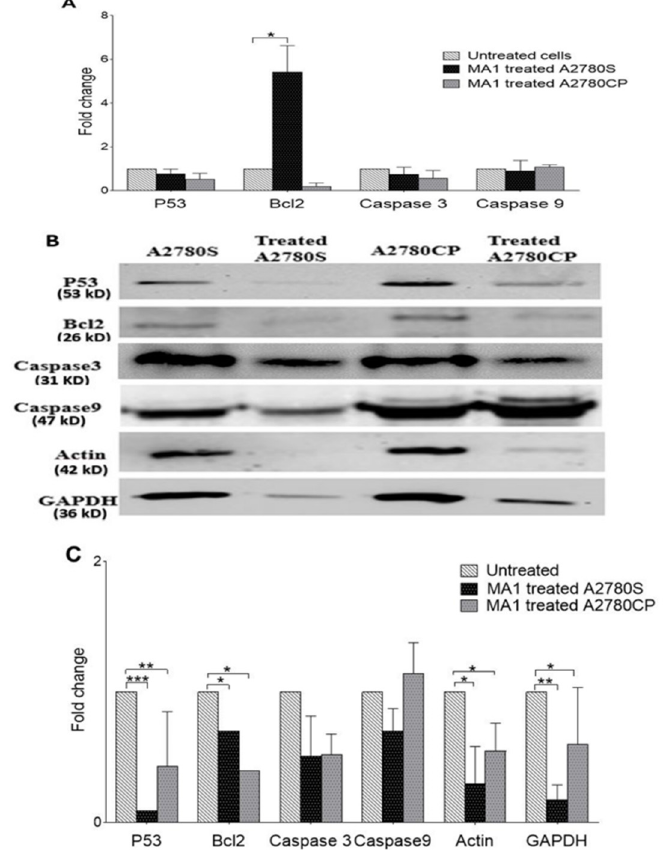
Figure 6. Expression of p53, Bcl2, and caspases3/9 genes’ analysis using quantitative RT-PCR and Western blot analysis: ( A ) RNA expression of p53, Bcl2, and caspases3/9 normalized to GAPDH. Protein expression of several genes in the ovarian cancer cells A2780S and A2780CP when treated with Malformin A1 for 24 h ( B , C ). The protein bands were normalized to the total load of protein using Coomassie blue staining. Data represent the mean ± SE of three experiments at each concentration. * p < 0.05 **. p < 0.01* **. p < 0.001.